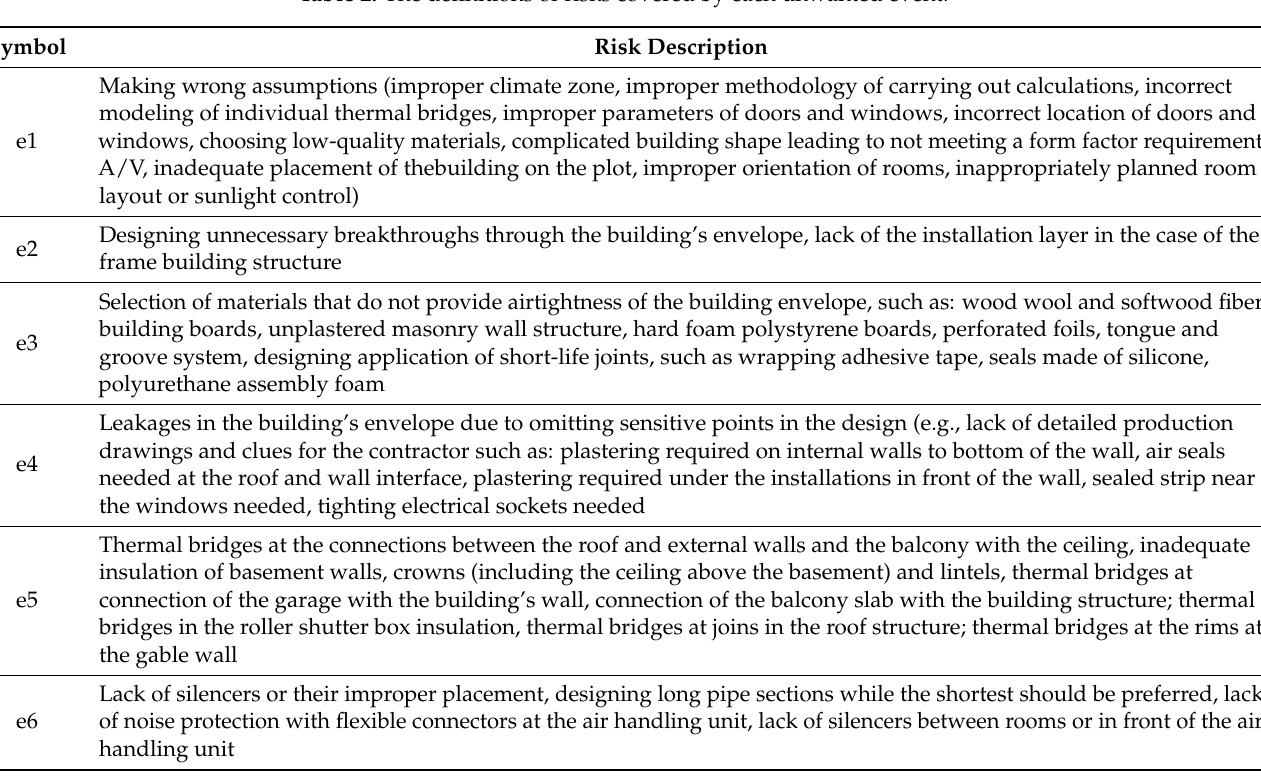
Table 2. The definitions of risks covered by each unwanted